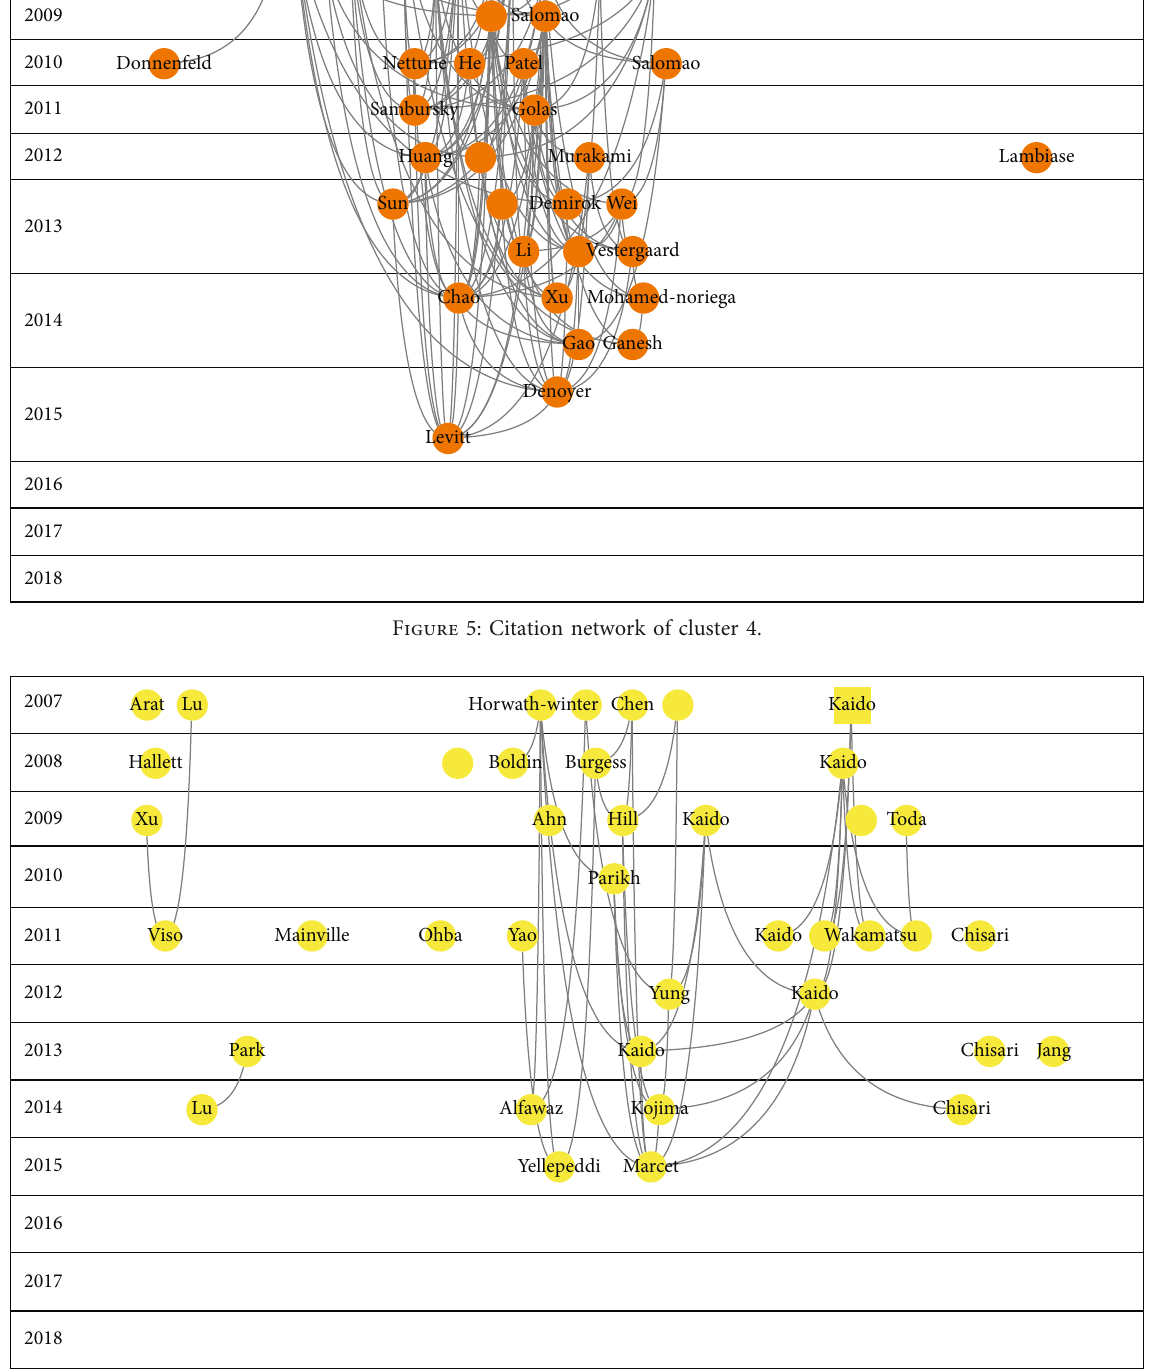
Figure 6: Citation network of cluster